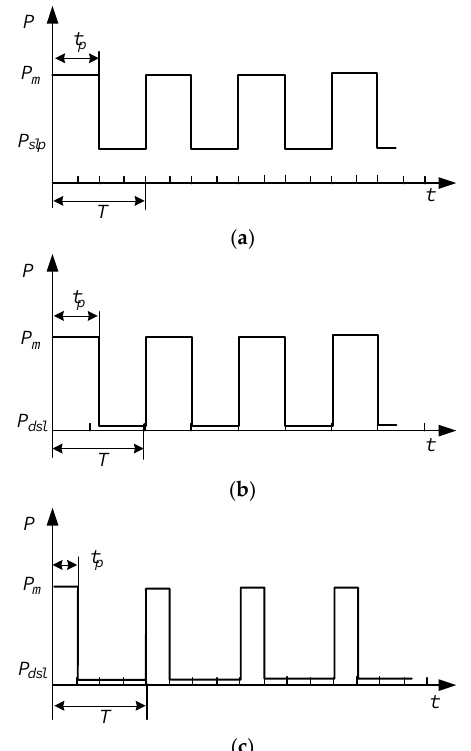
Figure 16. Illustration of power consumption under different sleep modes: ( a ) sleep periodic transmission, ( b ) deep sleep periodic transmission, ( c ) low-power deep sleep periodic transmission.